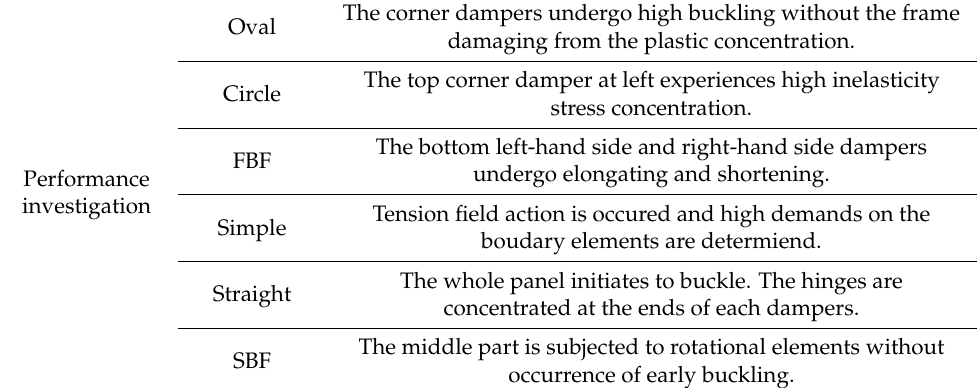
Table 7. The post-processing results for PRLs.